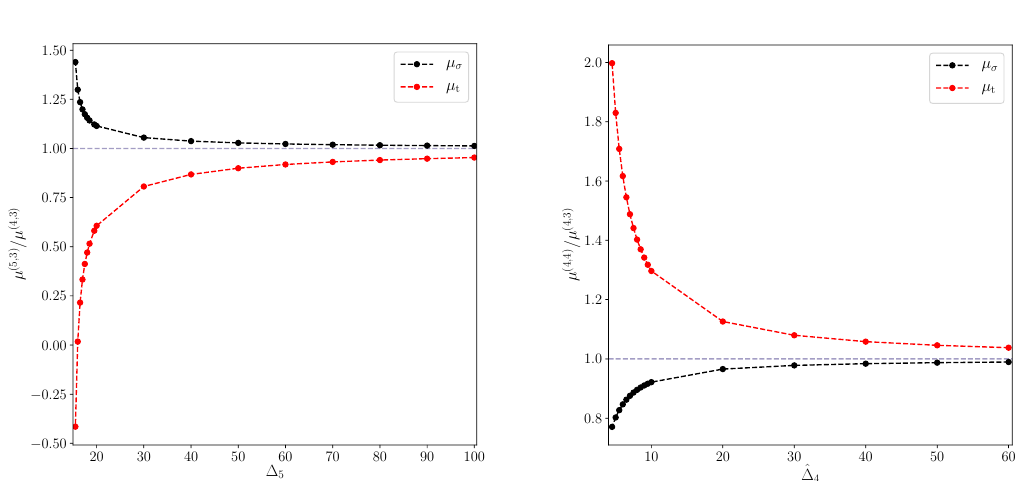
Figure 6: µ σ and µ for N = 2 from the one parameter families ( 5,3 ) (left) and t ( 4,4 ) (right) as functions of the dimension of the added operator in the respective channels. All values are normalized to the results from the ( 4,3 ) truncation so that → ∞ the graphs tend to 1 as ∆ , (cid:210) ∆ 5 4